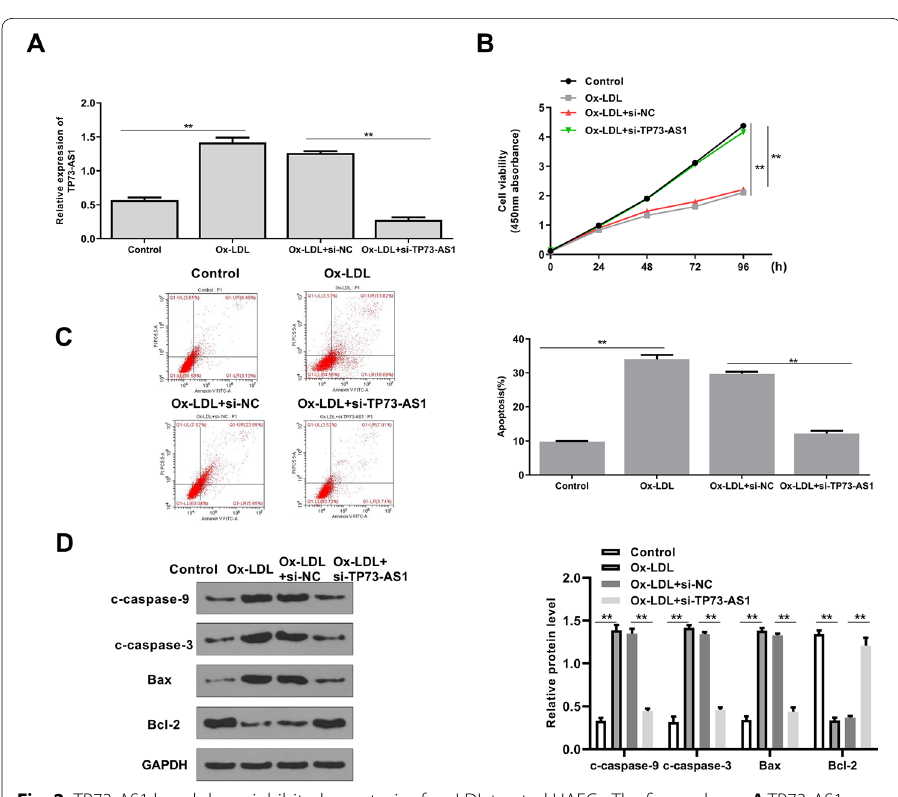
Fig. 2 TP73-AS1 knockdown inhibited apoptosis of ox-LDL treated HAECs. The figure shows A TP73-AS1 levels evaluated by qRT-PCR, B cell viability assessed by CCK-8 assay, C apoptosis evaluated by flow cytometry and D the levels of apoptosis-related proteins detected by Western blot in HEACs transfected with si-TP73-AS1 or si-NC, and treated with 50 μg/ml ox-LDL for 24 h. **P <